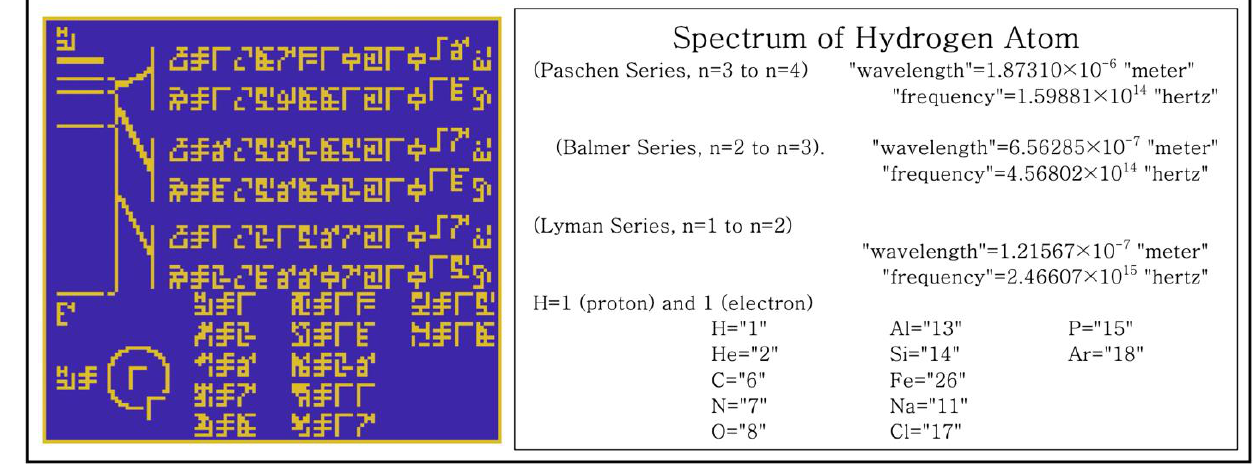
Figure 12. Most common elements in the message, Page